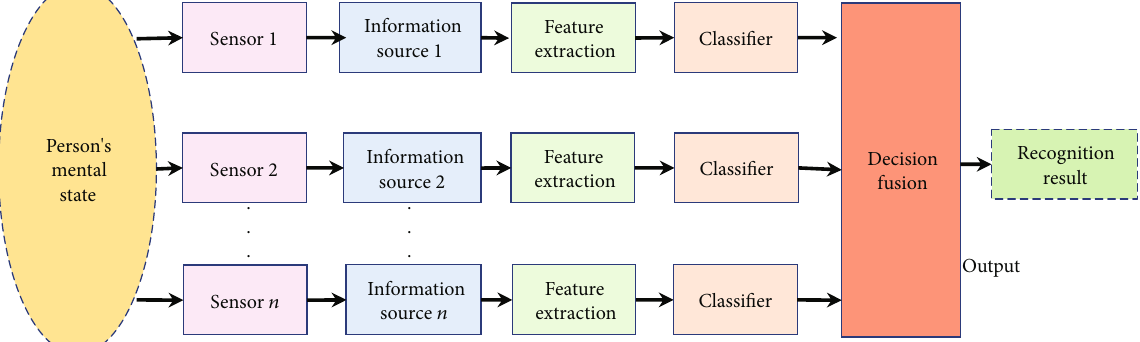
Figure 3: The decision-making layer fusion process diagram.